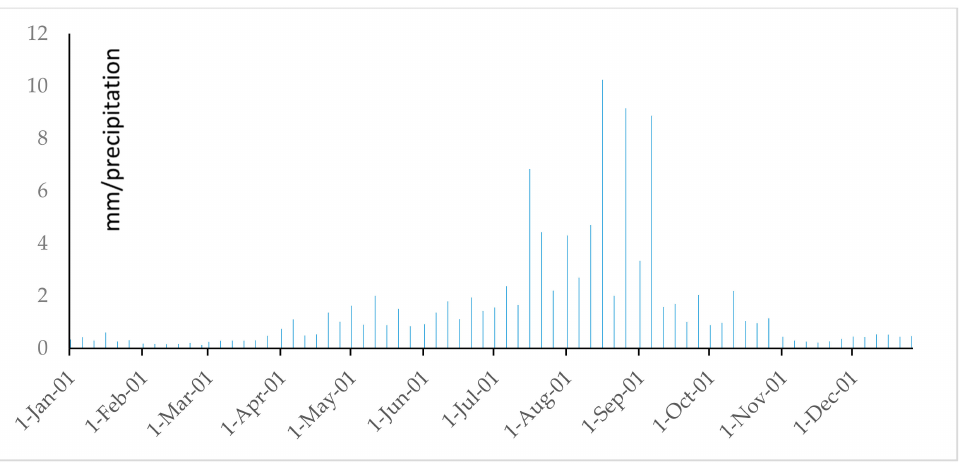
Figure A28. Precipitation of Denko County in 2000.